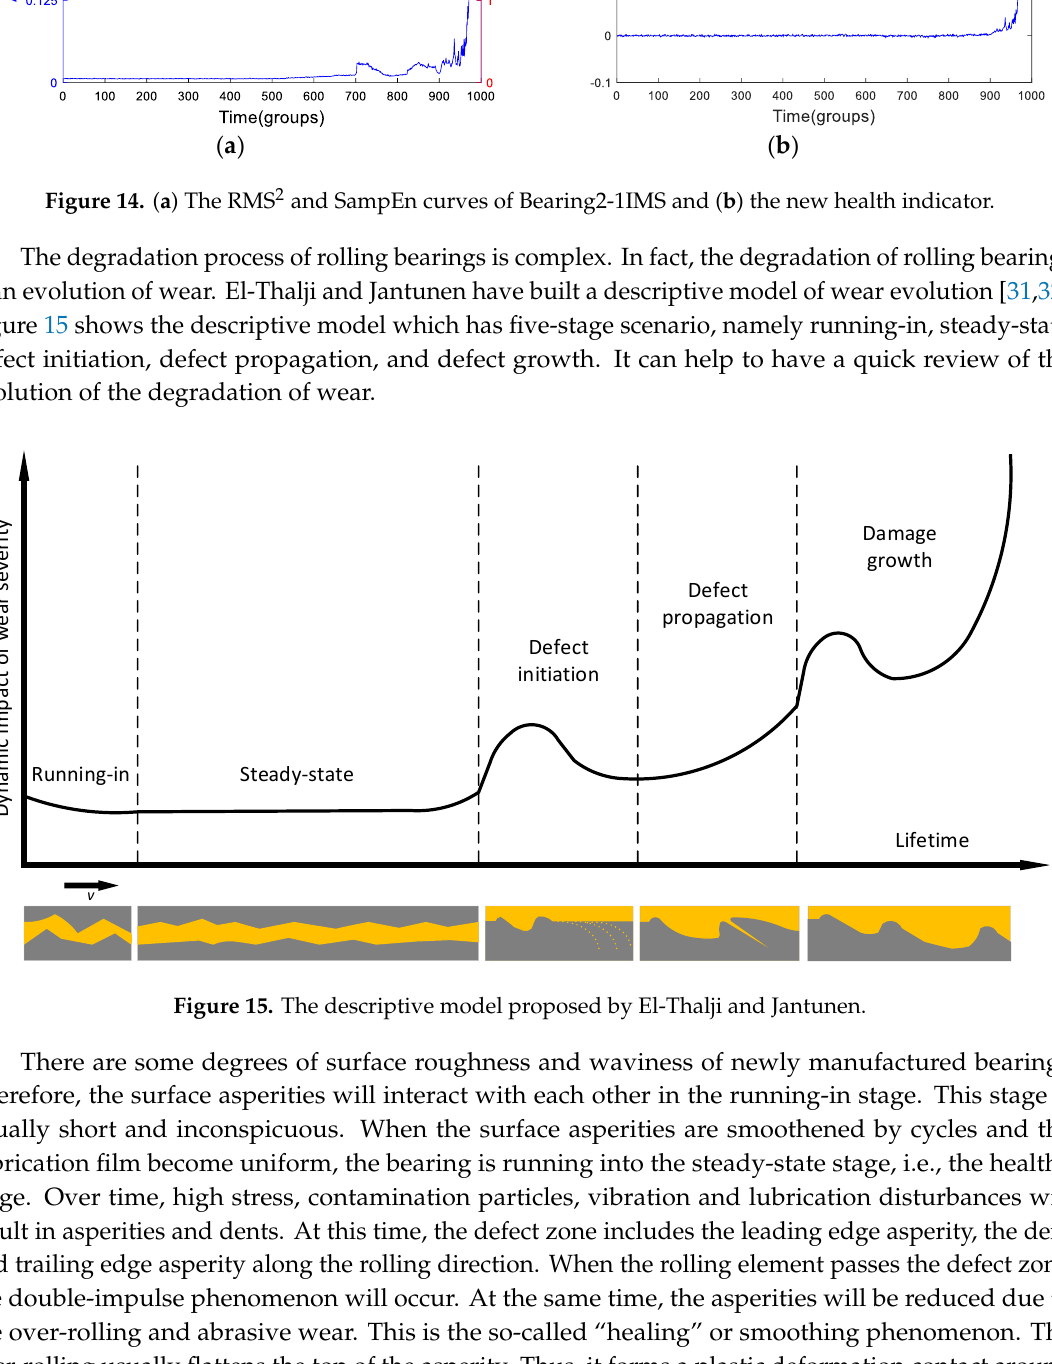
Figure 14. ( a ) The RMS 2 and SampEn curves of Bearing2-1IMS and ( b ) the new health indicator.